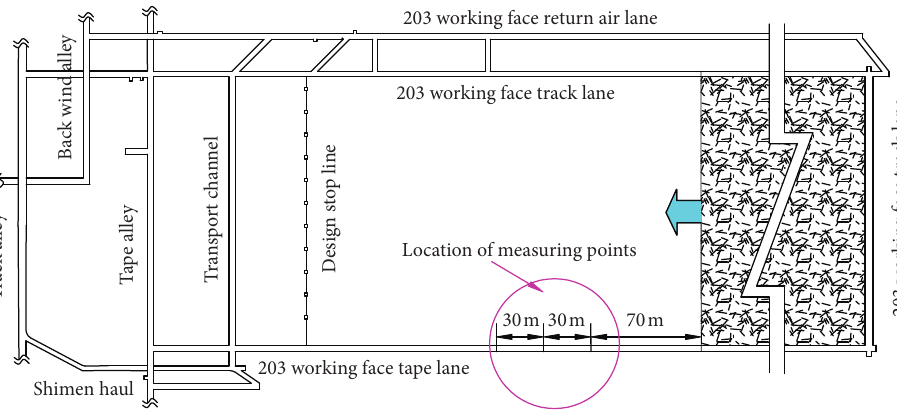
Figure 13: Plan view of measuring point arrangement